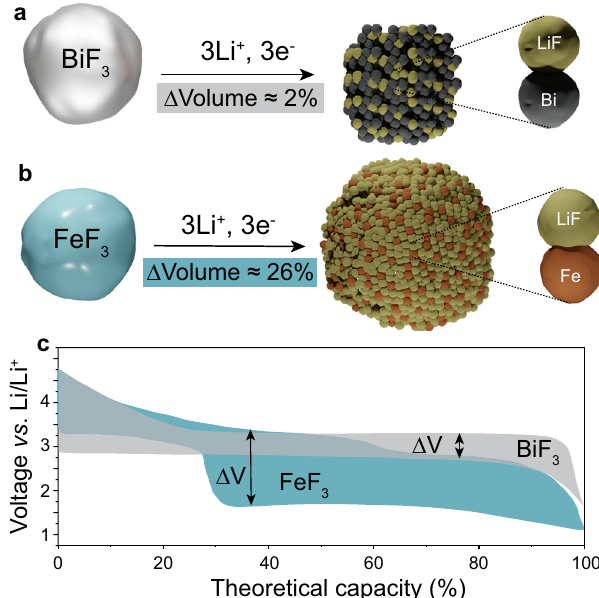
Fig. 1 Comparison of BiF 3 and FeF 3 conversion-type cathodes for Li-ion batteries. a , b Schematics of the volume expansion of BiF 3 ( a ) and FeF 3 ( b ) upon their lithiation. c The typical voltage pro fi les (taken from Ref. 24,25 .) and associated voltage hysteresis of BiF 3 and FeF 3 cathodes upon discharge (lithiation) and charge